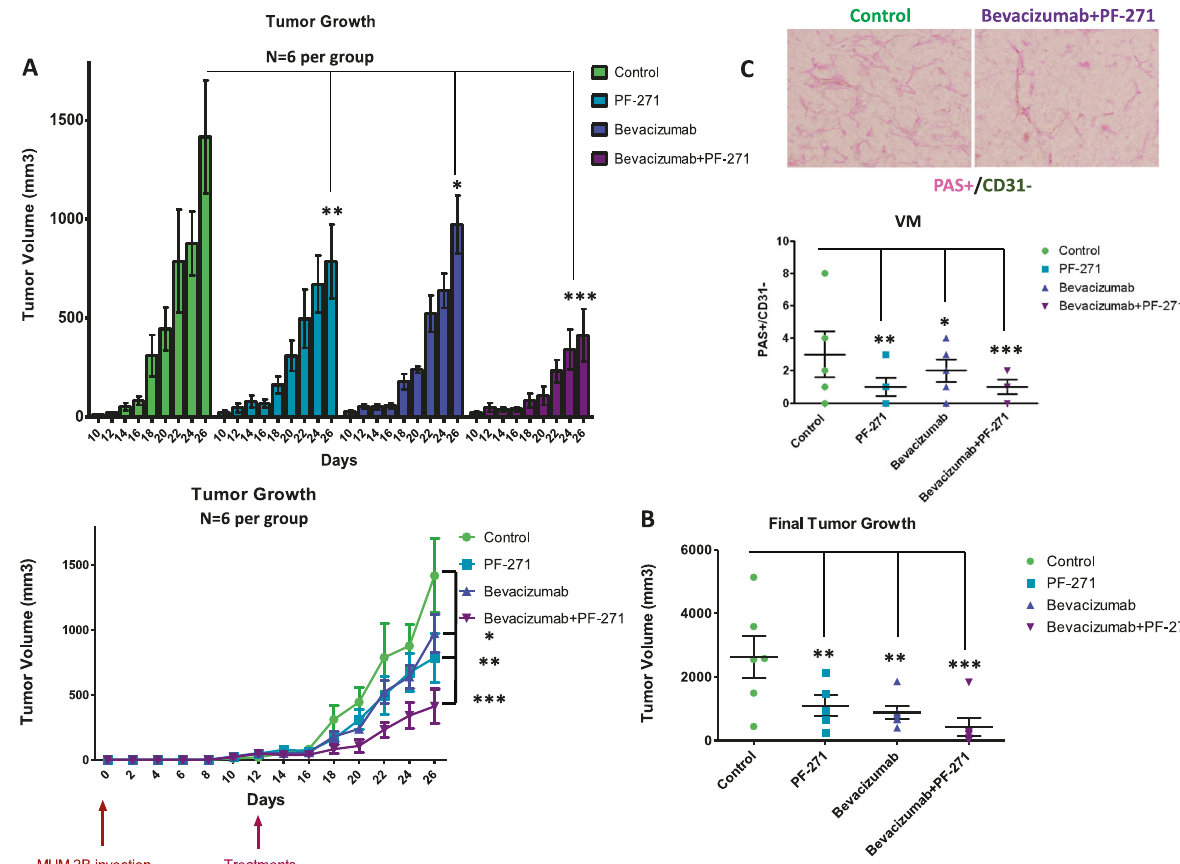
Fig. 7 FAK inhibition in combination prime line anti-angiogenesis Bevacizumab reduces the tumor growth in MUM 2B xenograft approach. A Tumor growth progression graphic representation on different days, the annotations of the tumor were every two days, being the day 12 post-injection of MUM 2B cells the beginning of different treatments. B Graphic representing fi nal tumor growth with the treatment ’ s groups ( N = 6). C Representative pictures of different tumors from treatment